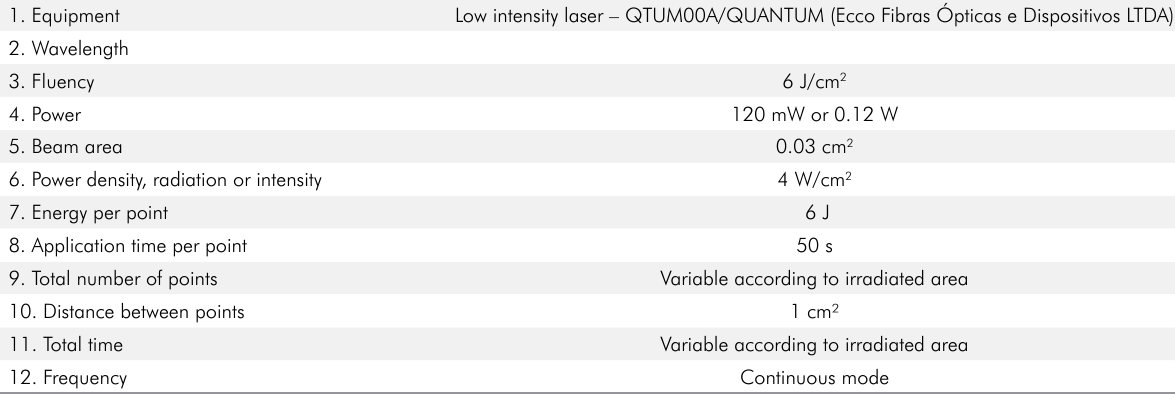
Chart 1. Characteristics of the laser radiation